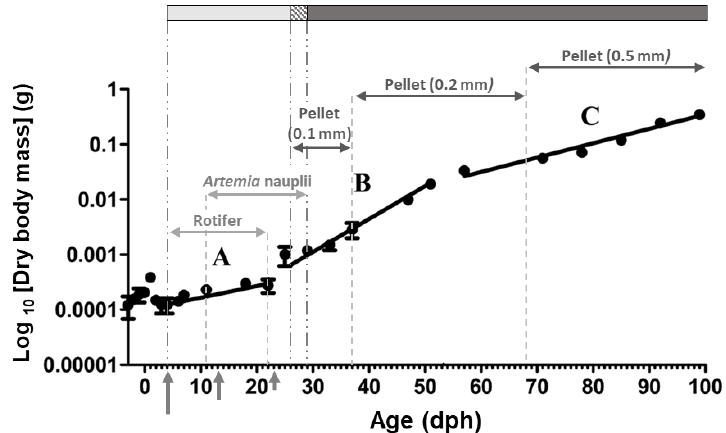
Figure 1. Growth pattern (Log 10 -transformed dry body mass) and feeding protocol for Chelon labrosus larvae utilized in the present study. Periods with different growth rates are indicated by letters A, B, and C (modified from Sarasquete et al. [10]). Long (4 dph), medium (13 dph), and short (23 dph) vertical arrows indicate mouth opening, onset of exclusively exogenous feeding, and proliferation of gastric glands, respectively. Light grey, dashed, and dark grey bars on top of the graph, represent periods with live prey, co-feeding, and inert diet, respectively.